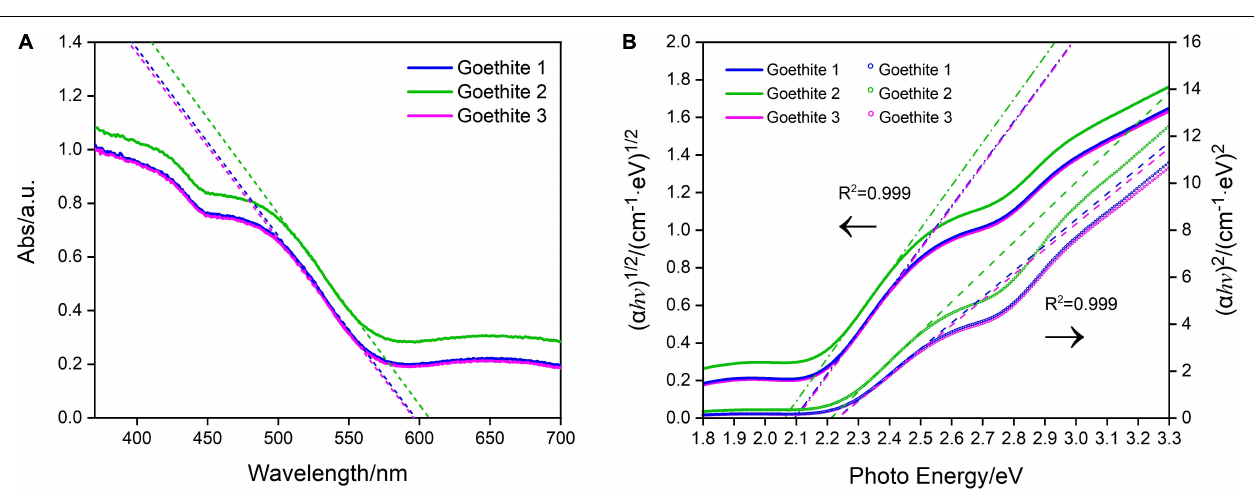
FIGURE 3 | Ultraviolet–visible absorption spectra (A) and Tauc plots of synthetic goethite electrodes for the direct and indirect band gaps (B)